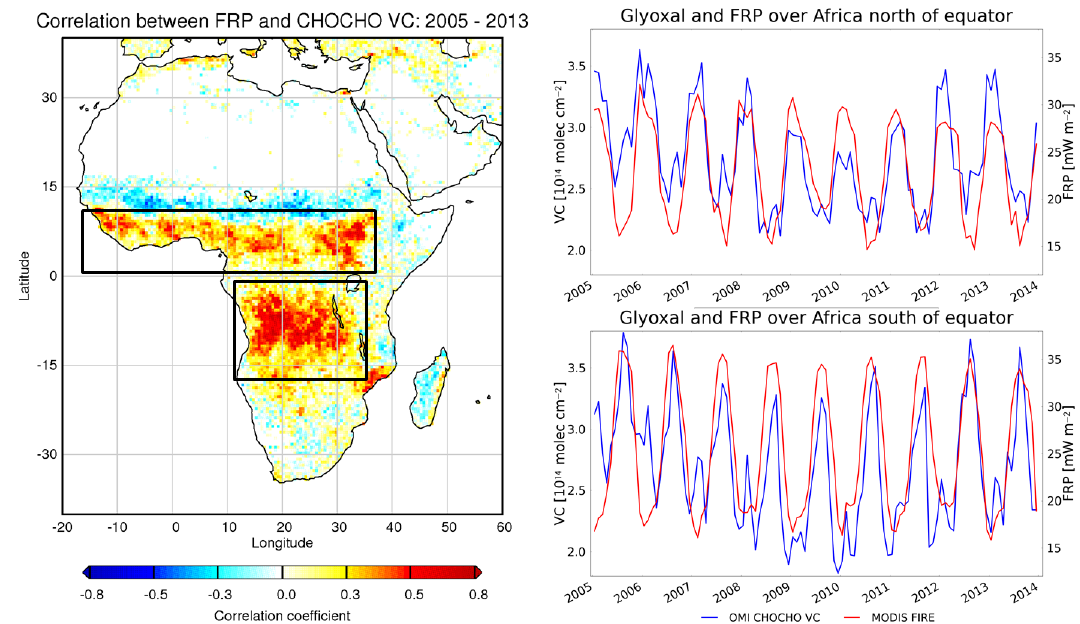
Figure 11. Pearson correlation coefficient (left) and seasonal variation (right) of FRP and CHOCHO VC over Africa from 2005 to